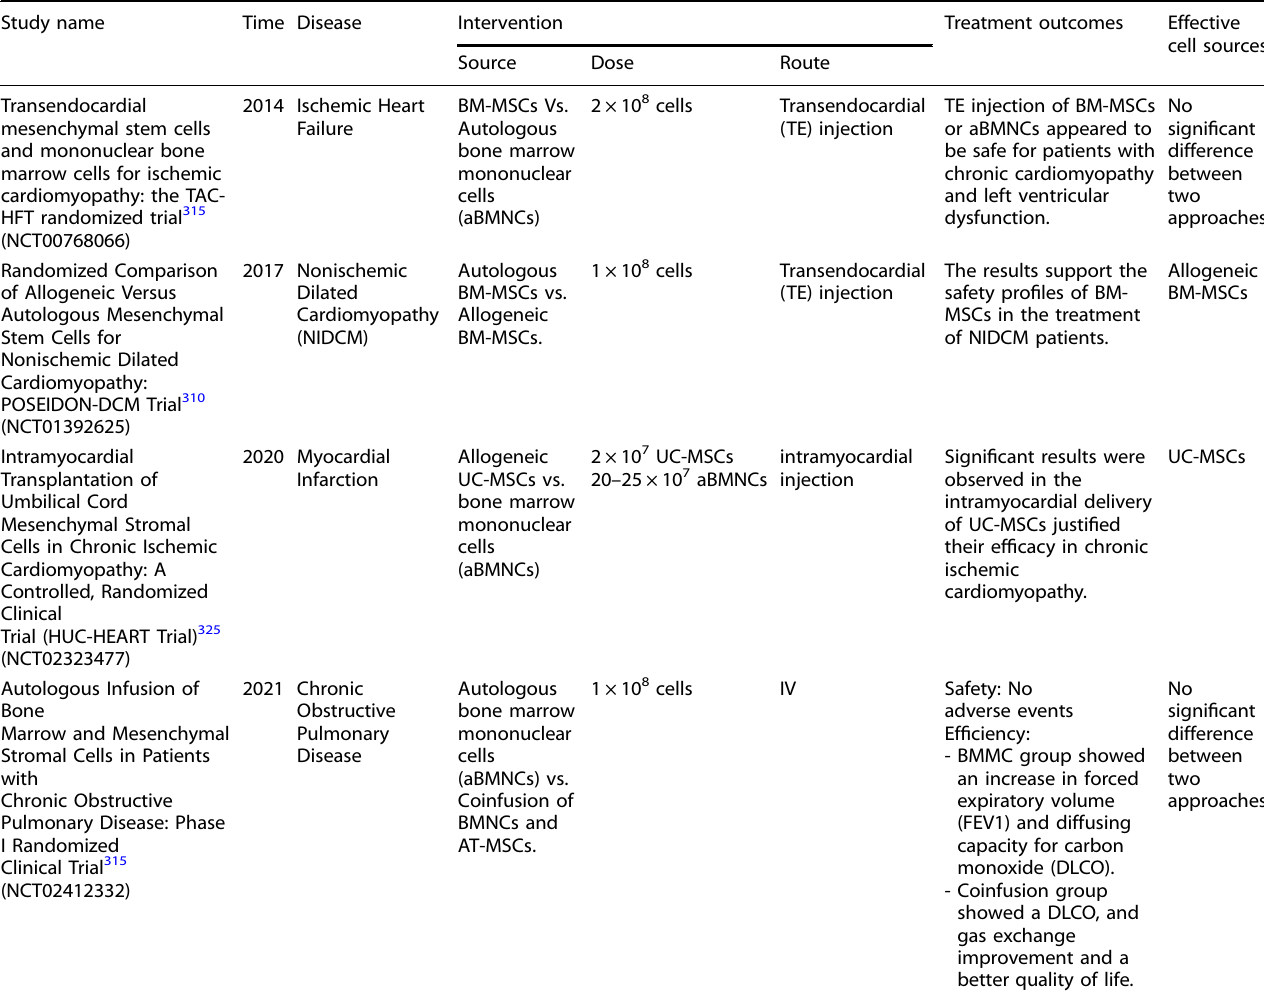
Table 6. Clinical trials comparing the ef fi cacy of MSCs derived from different sources in the treatment of pulmonary diseases and